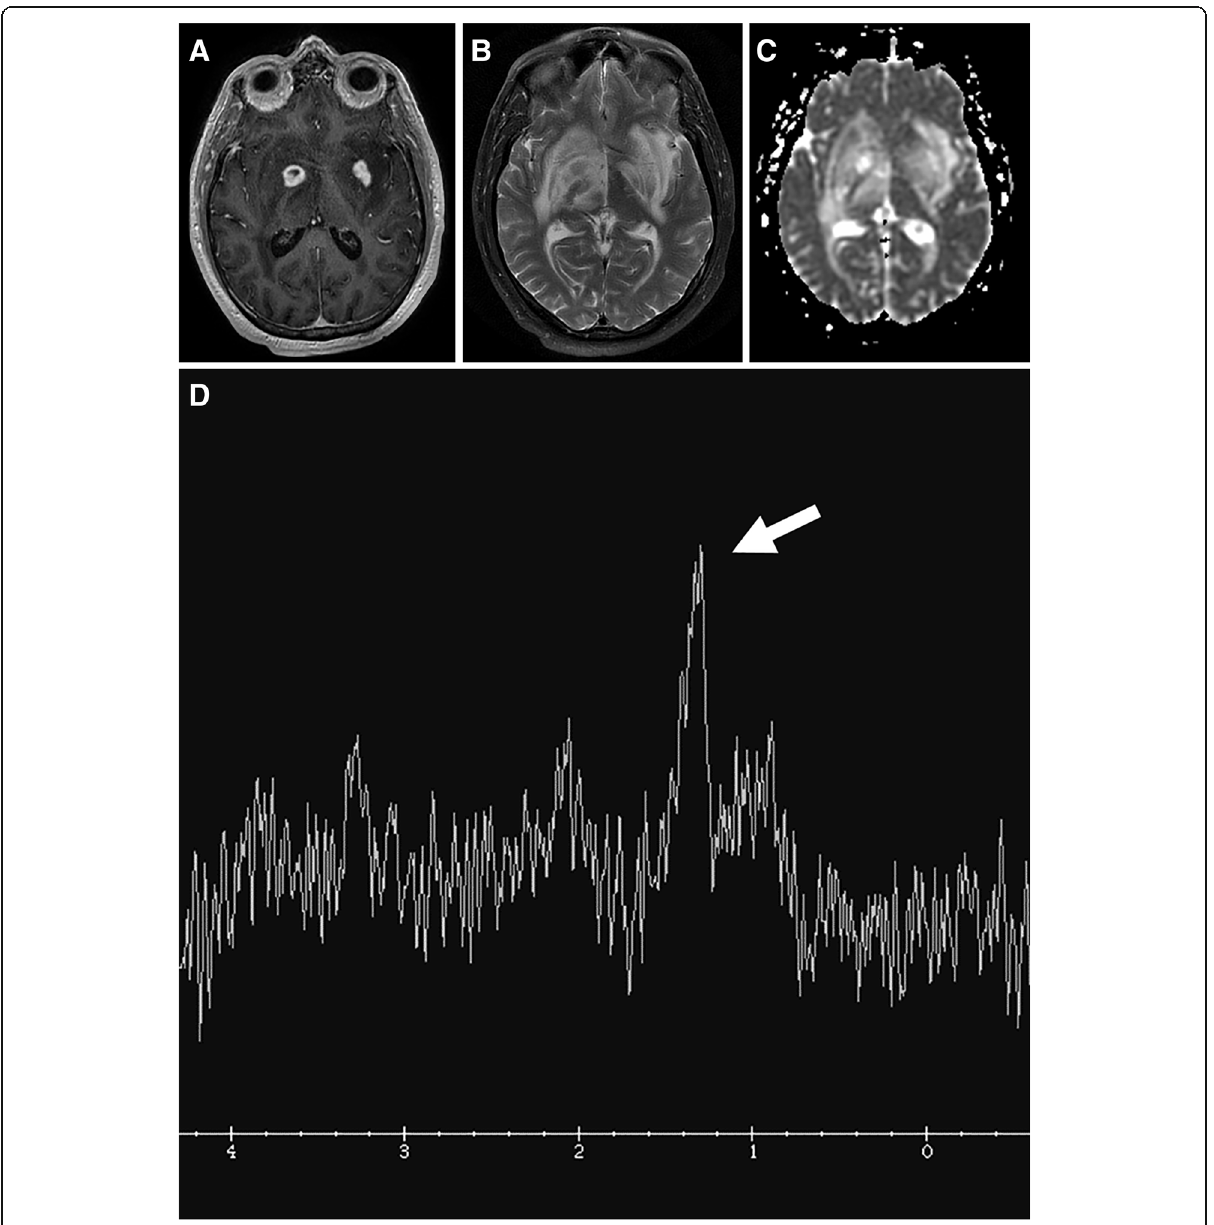
Fig. 10 Cerebral toxoplasmosis. T1-weighted image with gadolinium ( a ) shows multiple ring and nodular-enhancing masses in the basal ganglia. T2-weighted image ( b ) shows extensive edema. No obvious restricted diffusion in the lesions is present on the ADC map ( c ). Single voxel spectroscopy (TE = 35) ( d ) demonstrates elevated lipid/lactate peak (arrow) and all other peaks are